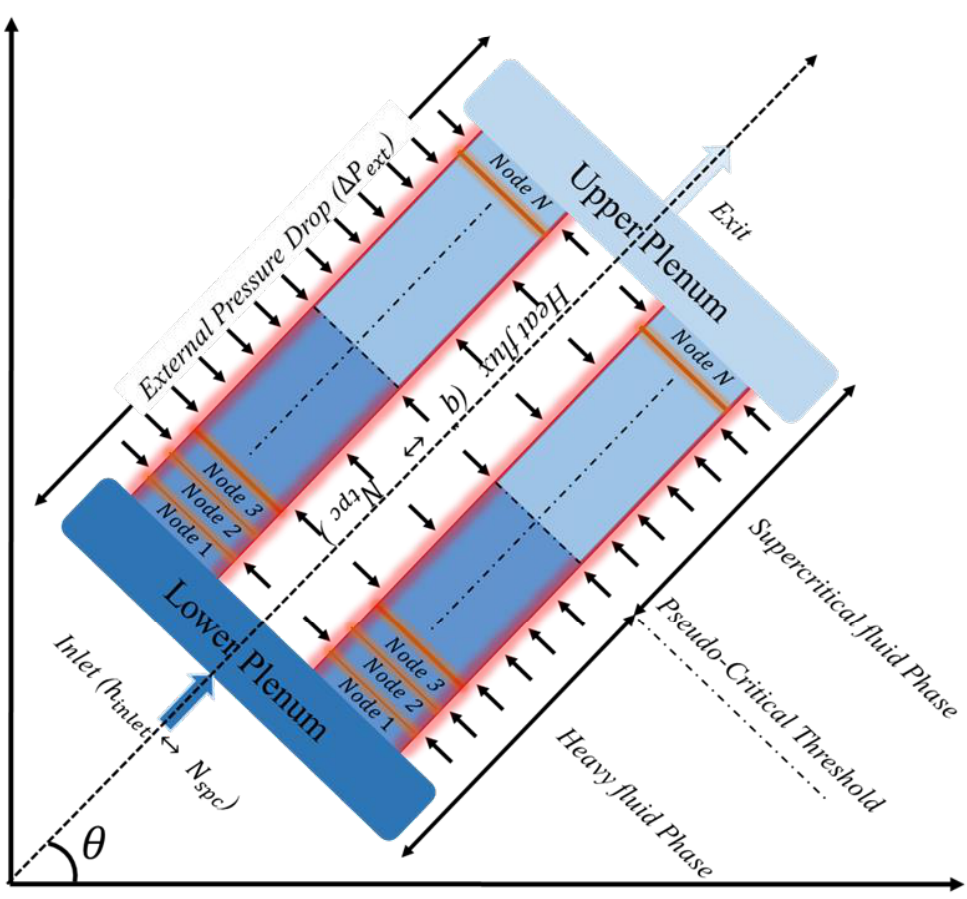
Figure 4. Schematic view of the inclined parallel heated channel system under supercritical pressure conditions.